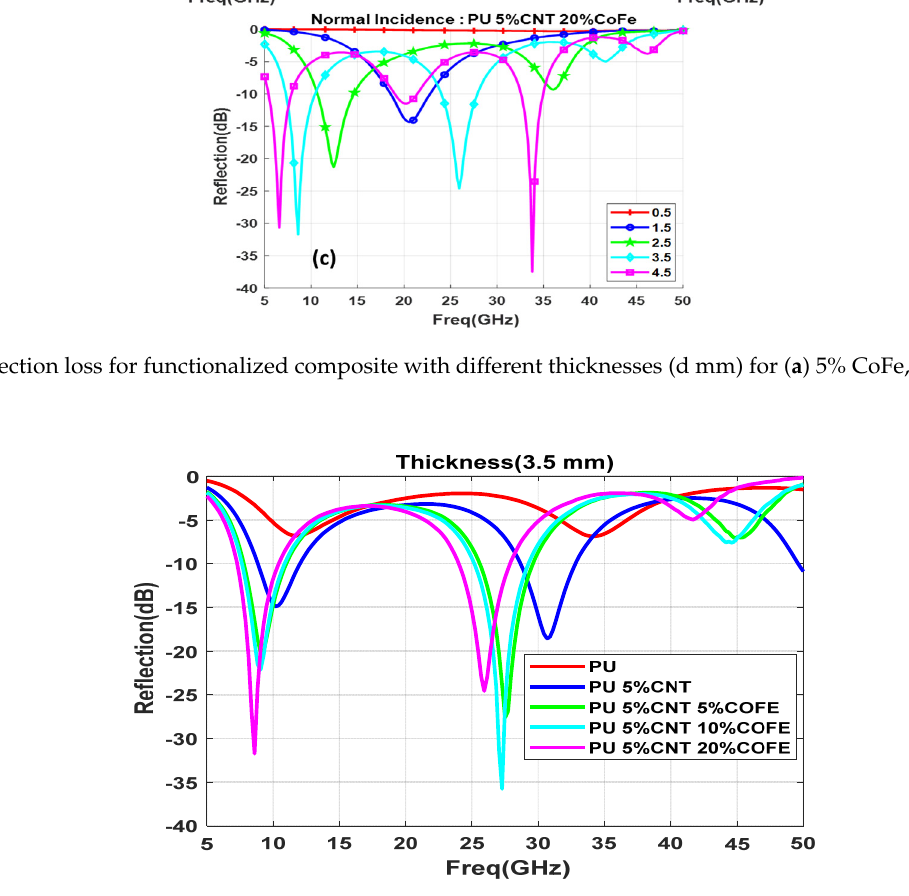
Figure 15. Reflection loss for different concentrations of CoFe at 3.5 mm thickness.